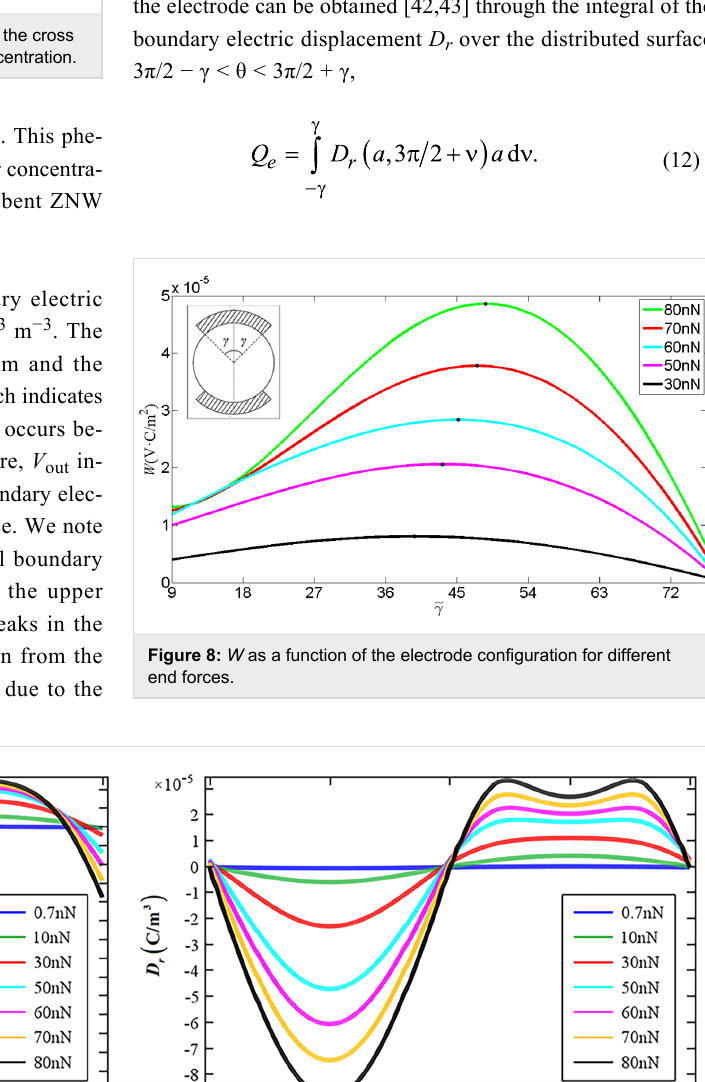
Figure 6: Output voltage V out between the two endpoints of the cross section of a bent ZNW as a function of the initial carrier concentration.